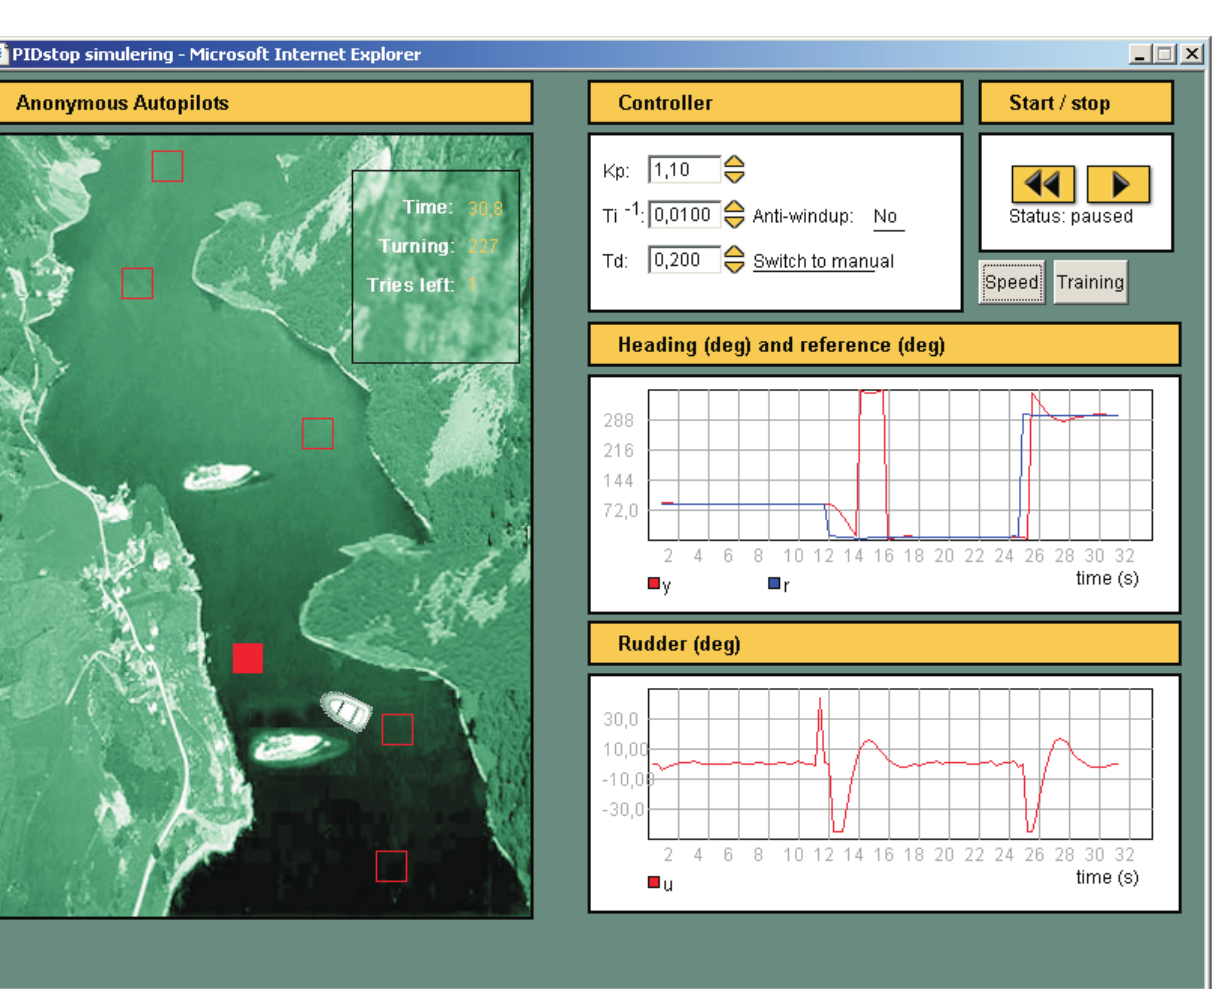
Figure 1: Tuning of a PID autopilot. In this exercise, the students tune a PID control law for a ship autopilot. The goal of the exercise is to ensure that the ship navigates a fjord by means of a set of way-points in the shortest possible time without hitting the shore or other vessels. The simulator requires only Java applets, and runs on standard computers. If the autopilot is well tuned, the speed of the ship can be increased. The students compete against each other in navigating the fjord in the shortest possible time. A high score list is kept to stimulate competition. The simulator is part of PIDstop, a system developed by Tore Bjølseth, a research assistent at